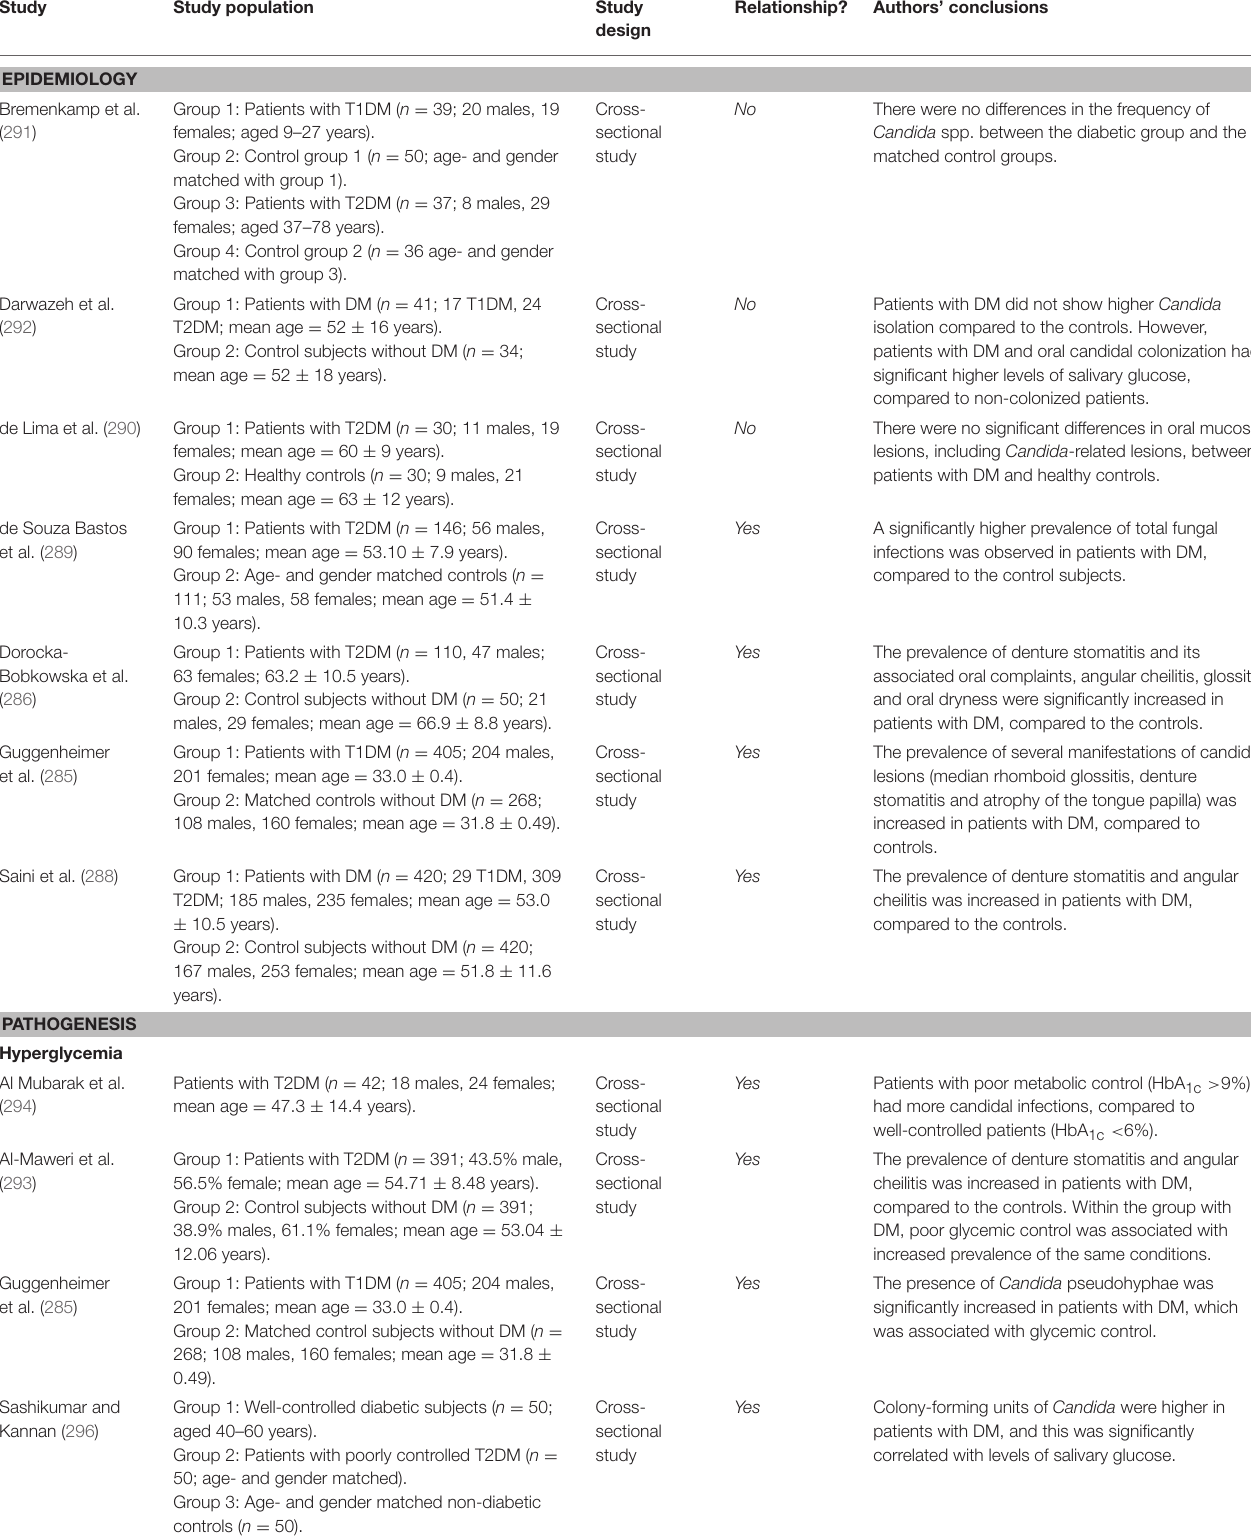
TABLE 5 | Overview of studies investigating the association between diabetes mellitus and oral candidal lesions. Study Study population Study